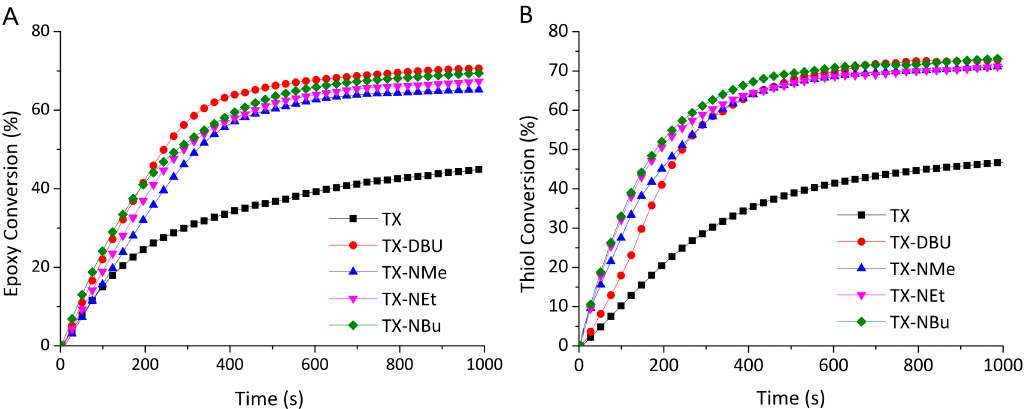
Figure 5. Conversion curves for photopolymerization initiated by the PBGs.